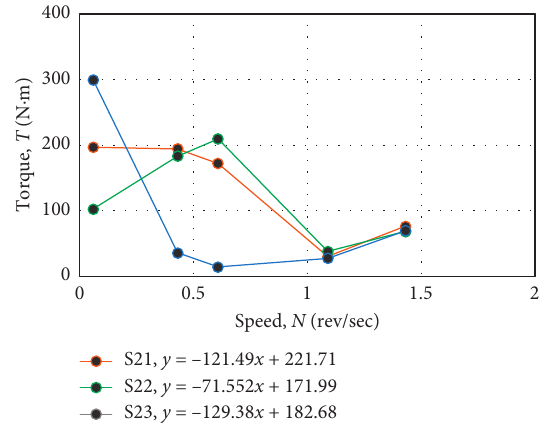
Figure 12: Torque for M30 grade concrete.